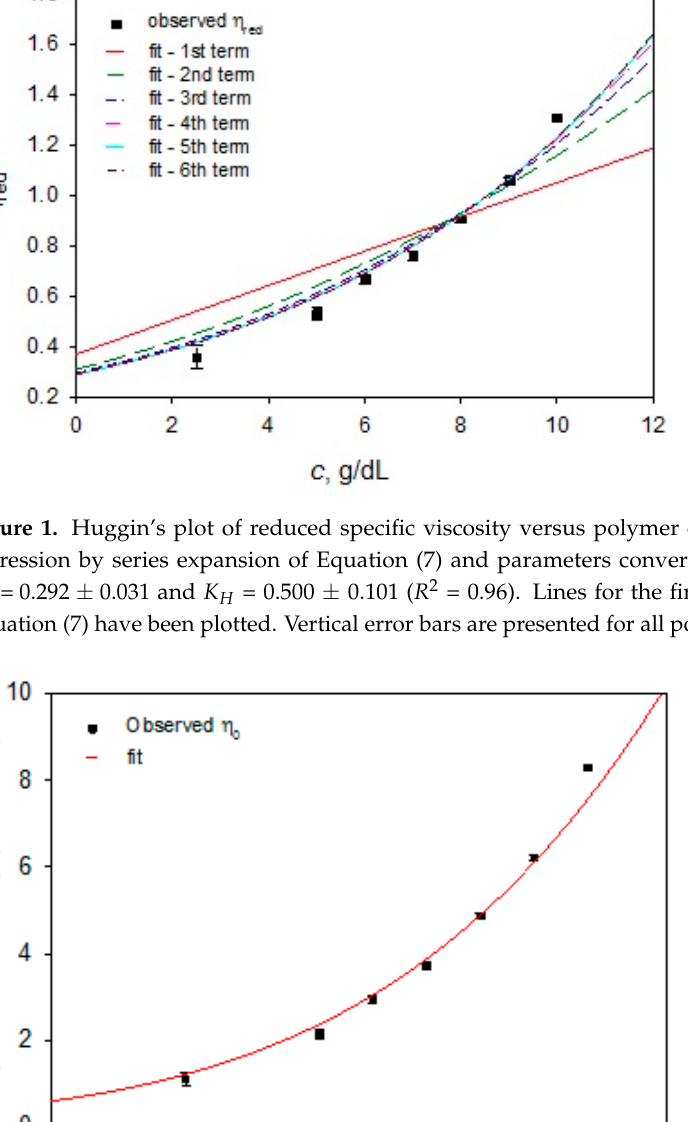
Table 1. Poly(methylmethacrylate) (PMMA) intrinsic viscosity estimated from Mark–Houwink parameters. Intrinsic viscosity estimates determined from Equation (10). Coefficients, K MH and a , were obtained from studies that utilized different analytical techniques. Presented results and referenced studies were performed at comparable temperatures.